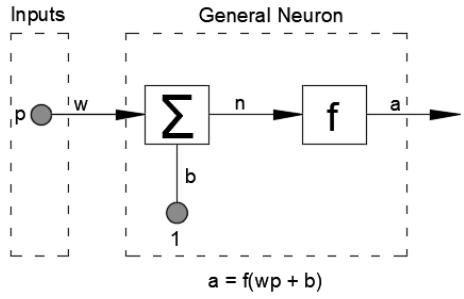
Figure 21. Basic Neural Network diagram [44].